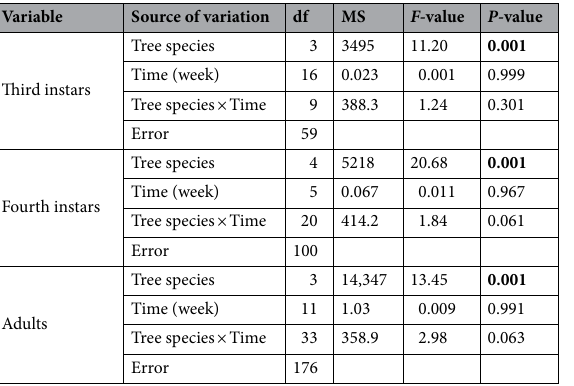
Table 1. Repeated measures binomial GLM ANOVA for data on the effect of tree species and time (week) on the proportion of Lycorma delicatula nymphs and adults present on individual trees in cages where they had access to Ailanthus altissima. df, degrees of freedom; MS, mean squares. Statistically significant values are indicated in